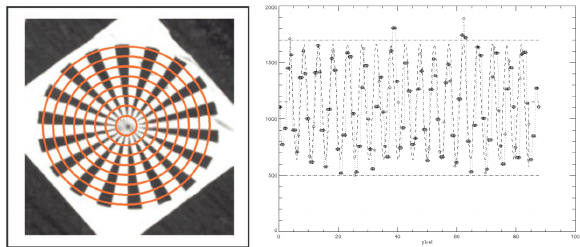
Figure 1. Designated test pattern Siemens star (left), radial modulation analysis for one circle (right) (Reulke et al.,